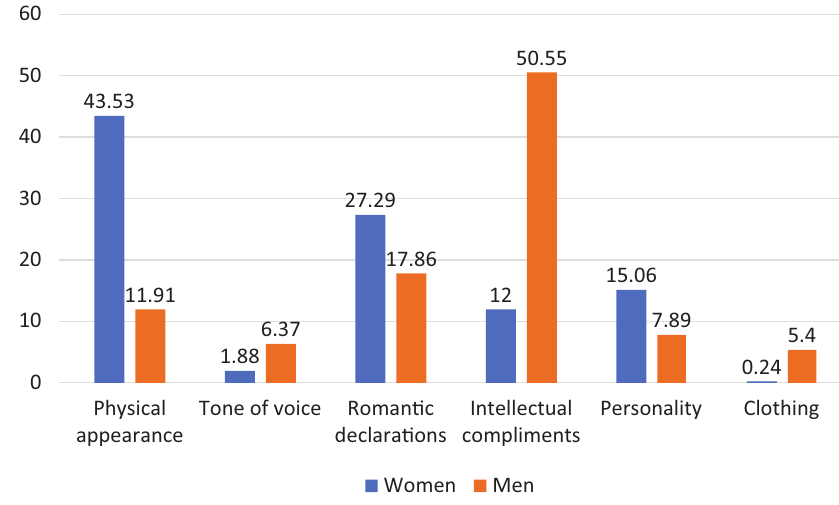
Figure 1. Differences by gender in the positive personal comments in science popularisation videos